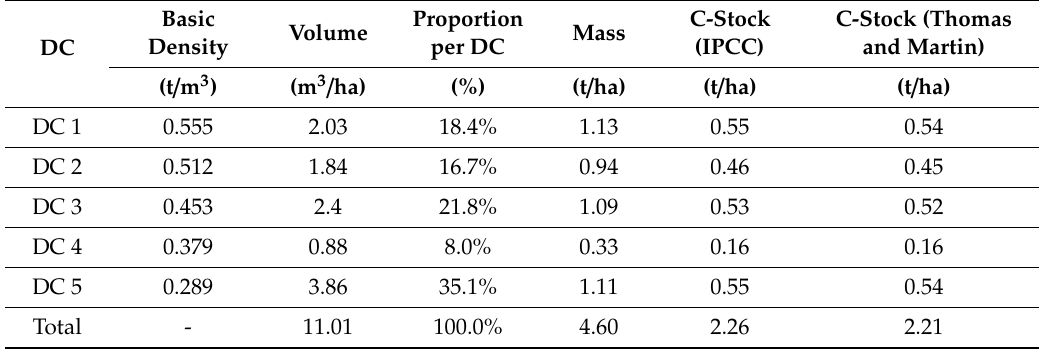
Table 9. Evergreen oak stand. Average values for the main parameters of deadwood and carbon estimated distribution per decay classes (DC) in evergreen oak